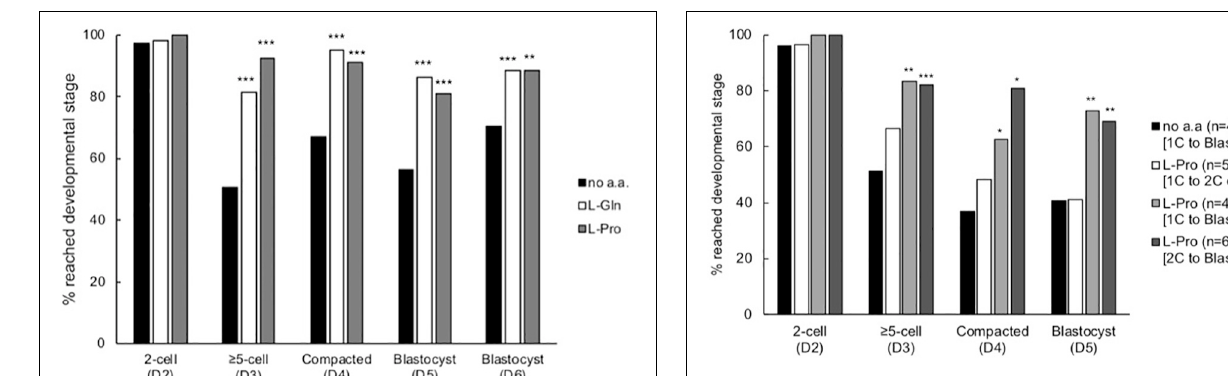
FIGURE 4 | Time-dependent effect of L-Pro and L-Gln on development of embryos cultured in isosmotic (270 mOsm/kg) medium at LD. Zygotes (20–22 post-hCG, D1 of development) were cultured for up to 5 days either in the absence of amino acids (no a.a.) or in the presence of 1 mM L-Gln or 400 µ M L-Pro and scored for development to the appropriate stage over the 5 days of culture. D indicates the day of development. A total of 79–158 individual embryos were analyzed from at least four independent biological replicates. ** P < 0.01; *** P < 0.001 indicates significant differences from the no amino acid control at each time point, analyzed by Chi-squared test.